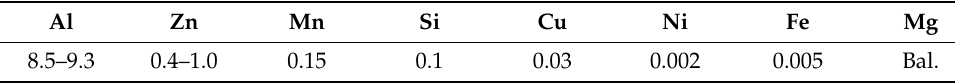
Table 1. Chemical compositions (wt.%) of AZ91 Mg